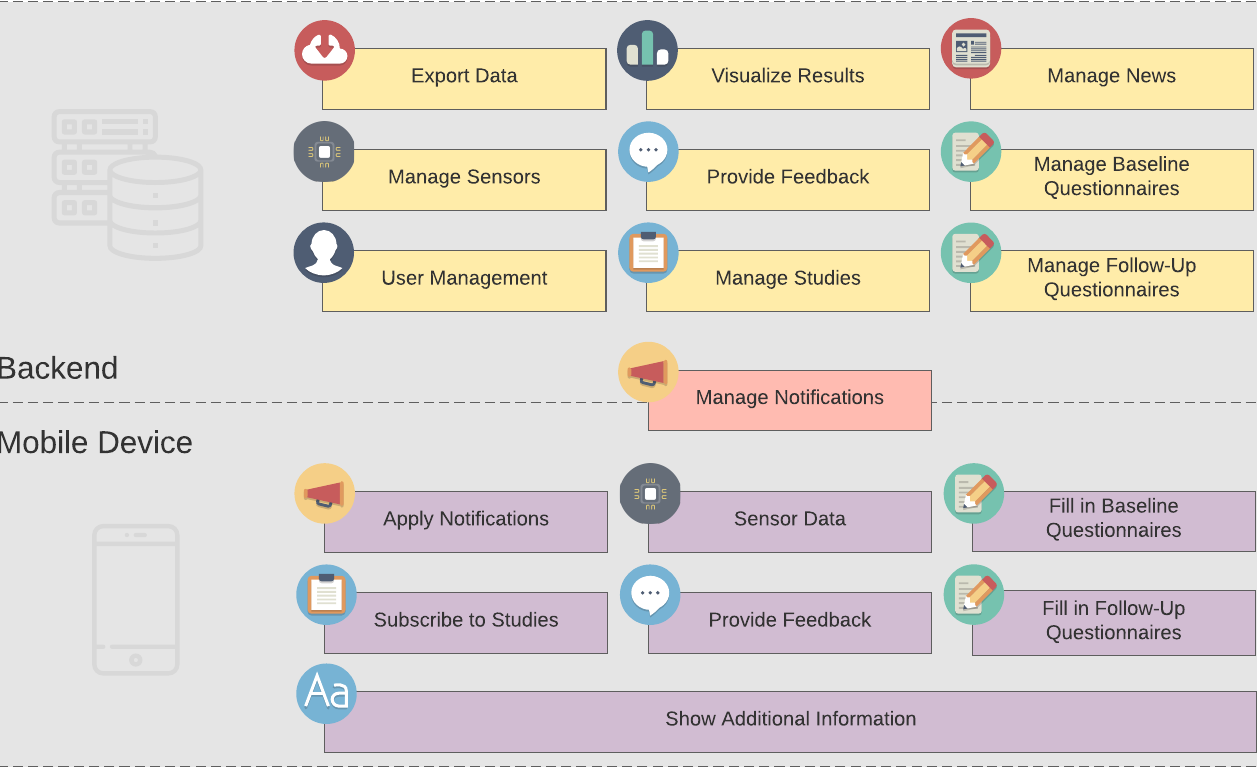
Figure 5. The core modules of Corona